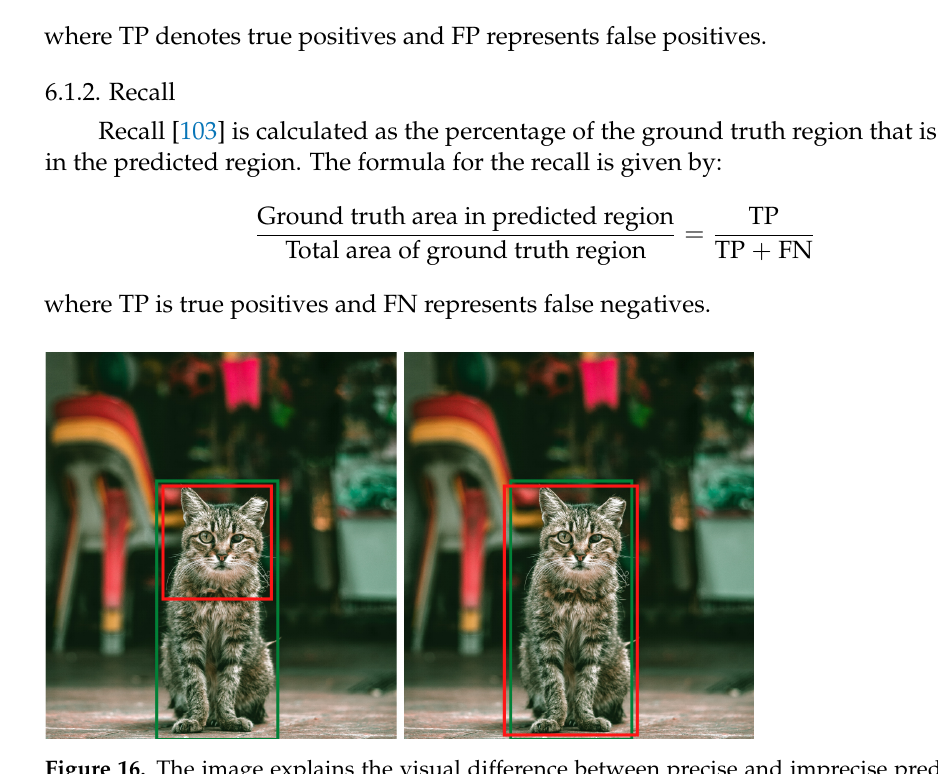
Figure 16. The image explains the visual difference between precise and imprecise prediction in object detection. The green color represents the ground truth, and the red color depicts the predicted boundary. Considering the IOU threshold value equals 0.5, the left prediction is not precise because the IOU between the ground truth and the inferred bounding box is less than 0.5. The bounding box prediction on the right side is precise because it covers almost the complete ground truth